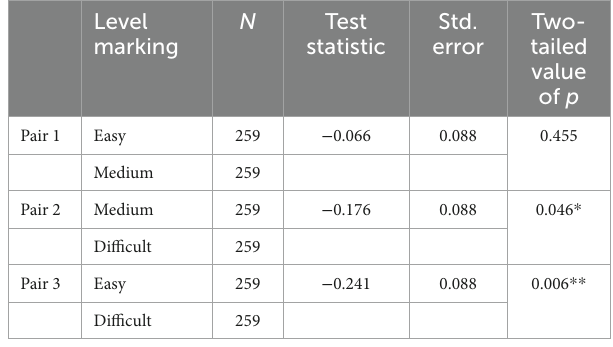
TABLE 6 Pairwise